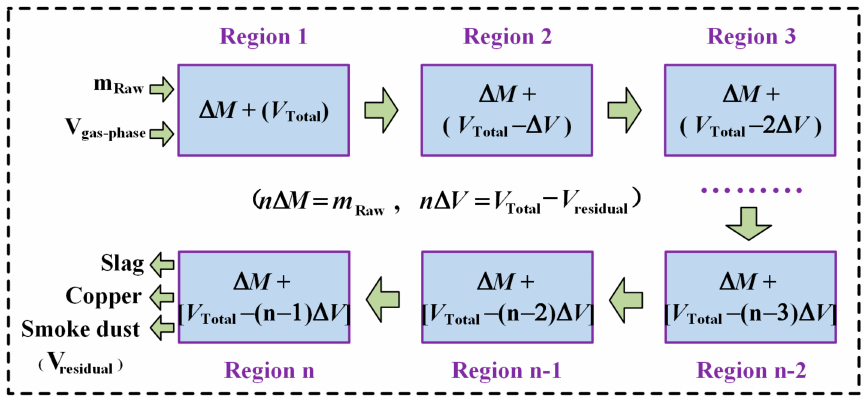
Figure 2. The local equilibrium physical model for top-blowing smelting of electronic